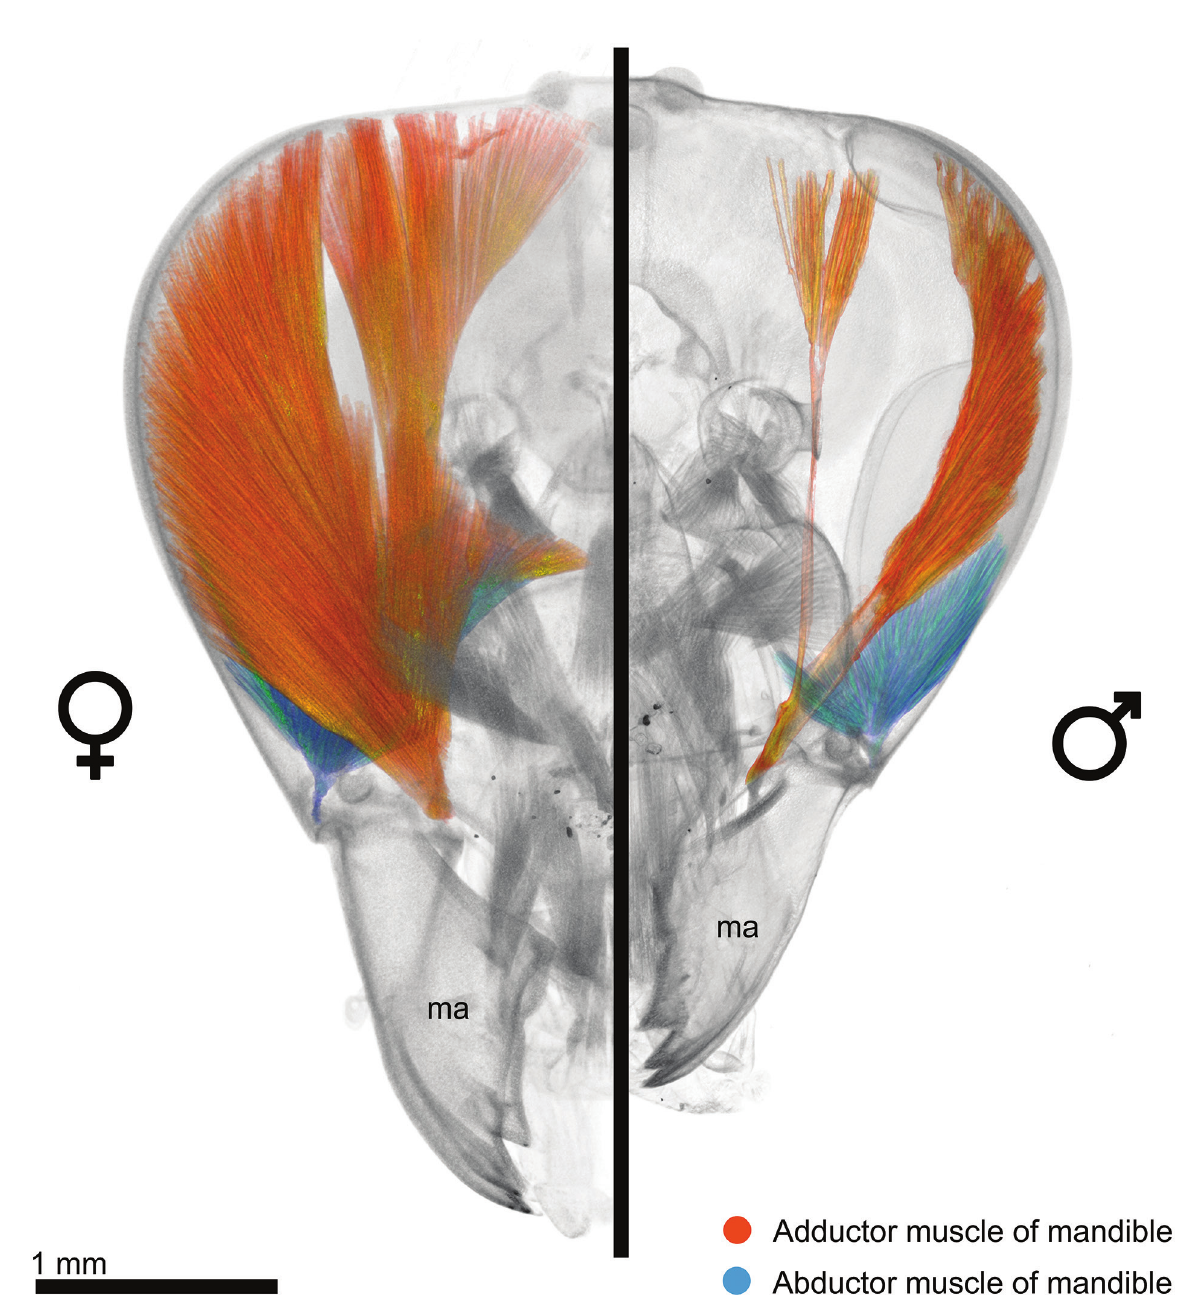
Figure 3. Head anatomy of a female worker (left) and a male individual (right) of V. germanica (micro CT). Adductor of the mandible (red) is much bigger in females than in males; abductor muscle (blue) is slightly bigger in females; ma –